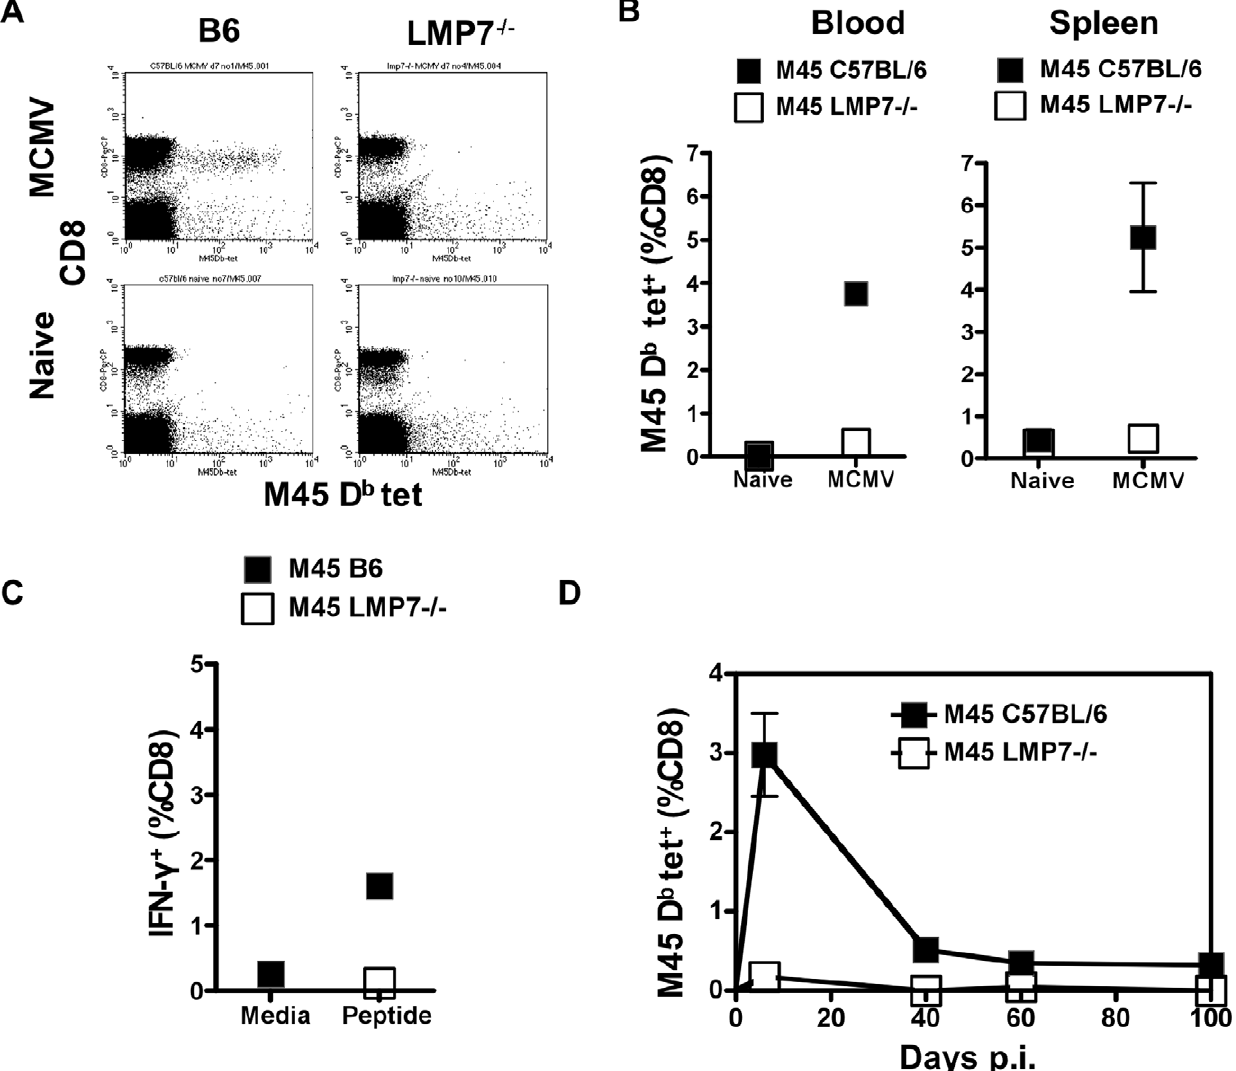
Figure 1. CD8 + T cell responses to M45 in LMP7 2 / 2 mice infected with MCMV. A. LMP7 2 / 2 mice and C57BL/6 control mice were injected intravenously (i.v.) with 1 6 10 6 plaque forming units (pfu) MCMV or an equivalent volume of phosphate buffered saline (PBS). Seven days p.i. peripheral blood was sampled by tail bleed. Whole blood was stained with fluorochrome-conjugated soluble tetrameric complexes (M45 H-2 D b 985 HGIRNASFI 993 ) and anti-CD8 antibody, and red blood cells lysed, before analysis by FACS. B. Lymphocytes were prepared from peripheral